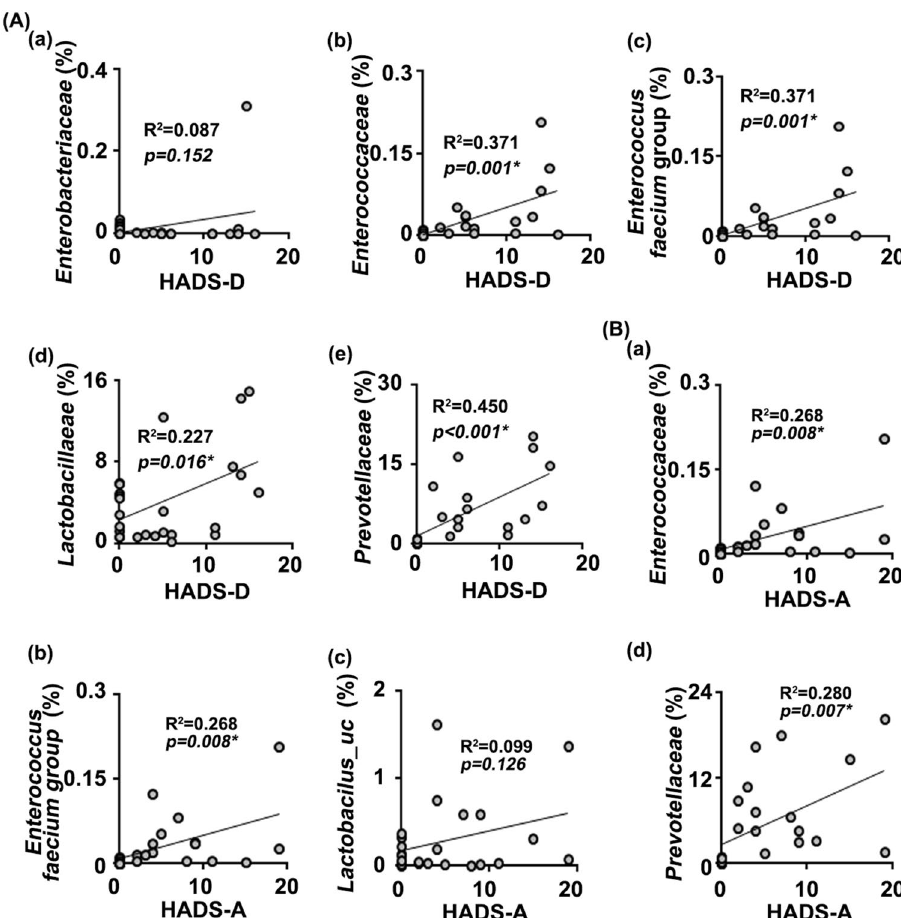
Figure 6. The relationship between HADS and gut microbiota composition. ( A ) The relationship between HADS-D and gut microbiota composition: (a) Enterobacteriaceae , (b) Enterococcaceae , (c) Enterococcus faecium group, (d) Lactobacillaceae , and (e) Prevotellaceae . ( B ) The relationship between HADS-A and gut microbiota composition: (a) Enterococcaceae, (b) Enterococcus faecium group, (c) Lactobacillus_uc, and (d) Prevotellaceae . n was 18 (HV n = 6; IBD/D − n = 8; IBD/D + n = 7). NC n = 6; HV-F n = 4; IBD/D − n = 8; IBD/D + n = 7: each n value is the average obtained from 3